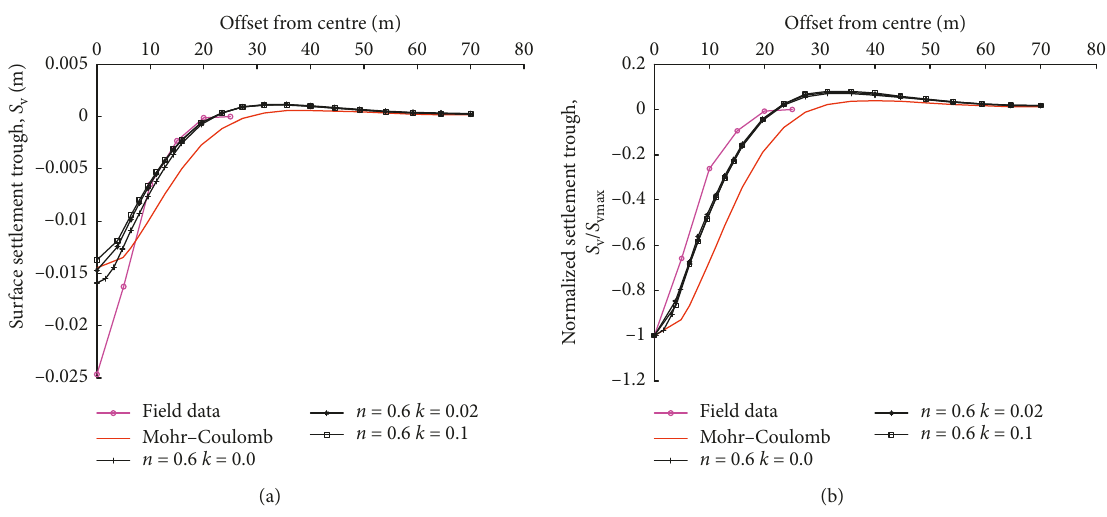
Figure 9: (a) Vertical displacement and (b) normalized settlement profiles with various values of k ( β � 0 °